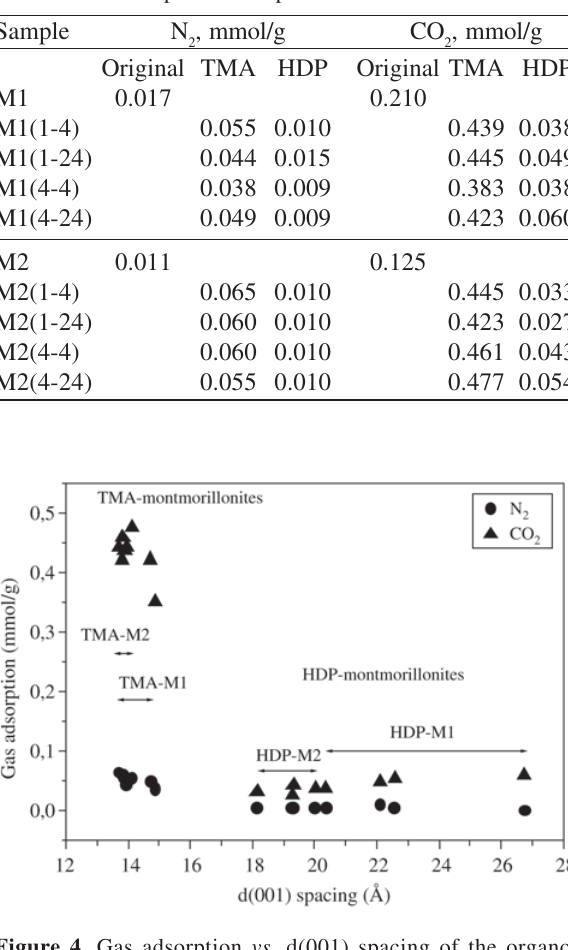
Table 2. Gas adsorption of samples at 25 °C and 0.1